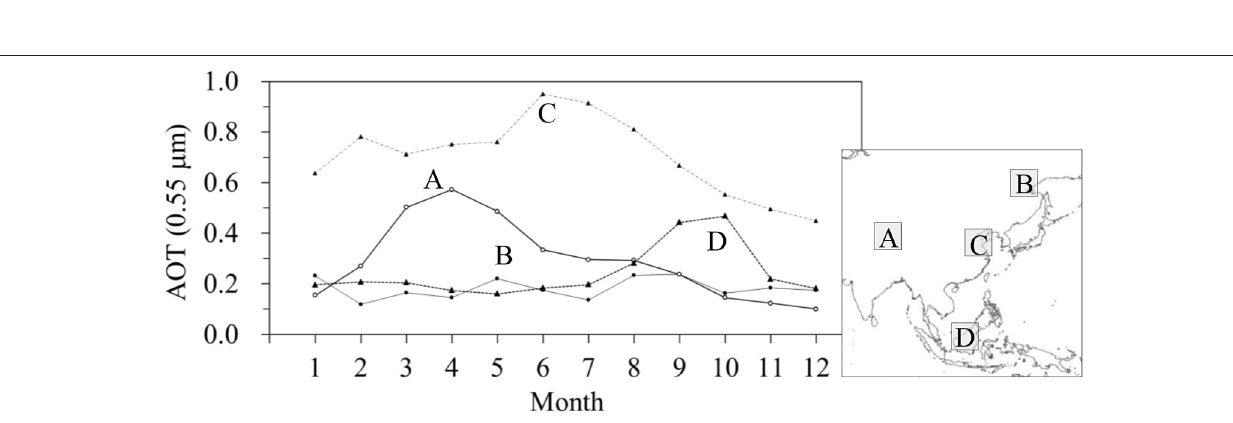
FIGURE 2 | Monthly mean AOT at a wavelength of 0.55 µ m from 2003 to 2016 derived from NASA/Aqua/MODIS (MYD08_M3 Collection 6) averaged over each region A to D denoted in the map on the right. The MODIS products in this image are cited according to the citation rules of NASA. No further permission is required for the image